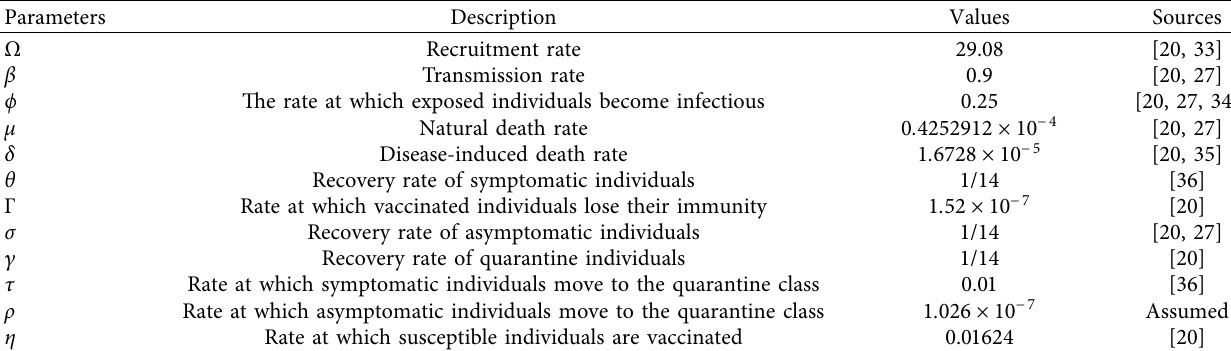
Table 1: Parameter values and description.